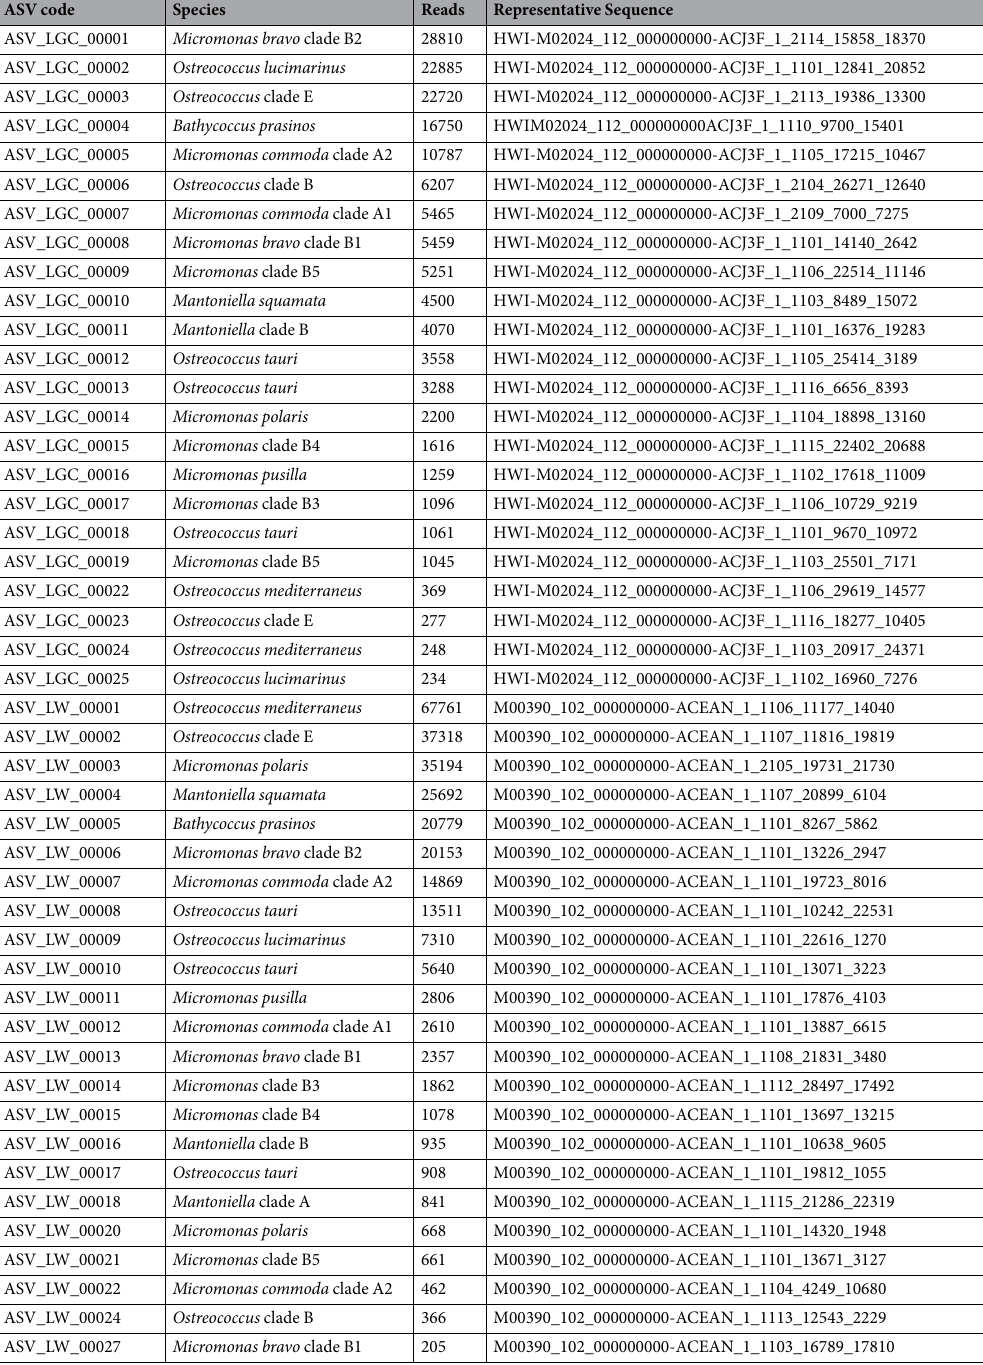
Table 1. Major Mamiellophyceae amplicon single variants (ASVs) from the LGC and LW datasets: taxonomic assignation, total abundance and representative sequences